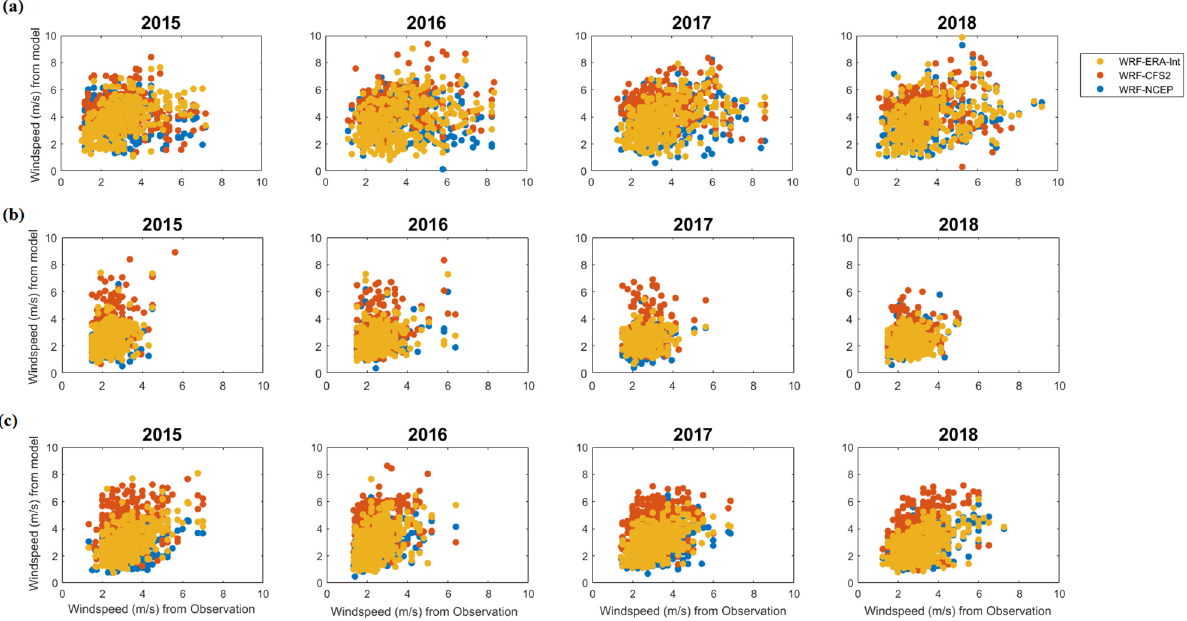
Figure A1. Daily average wind speed in m s − 1 from the models and observations at the onshore locations ( a ) Shaoguan, ( b ) Nanping, and ( c ) Ganzhou.